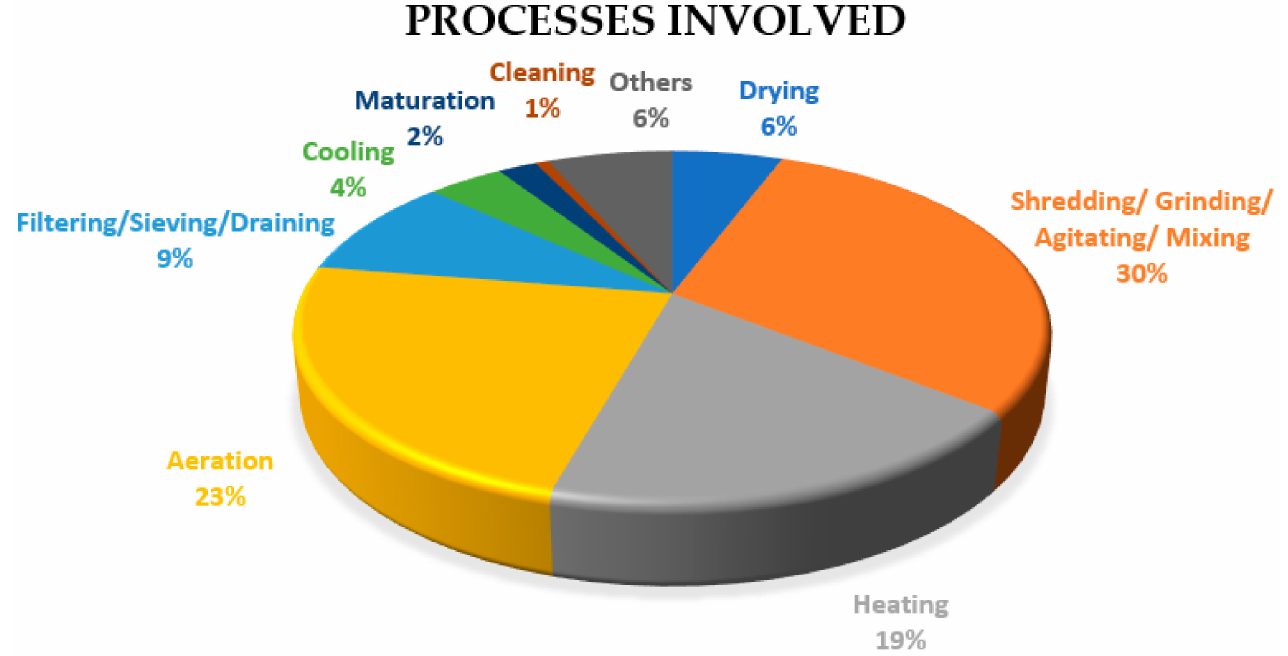
Figure 15. Processes involved for the selected